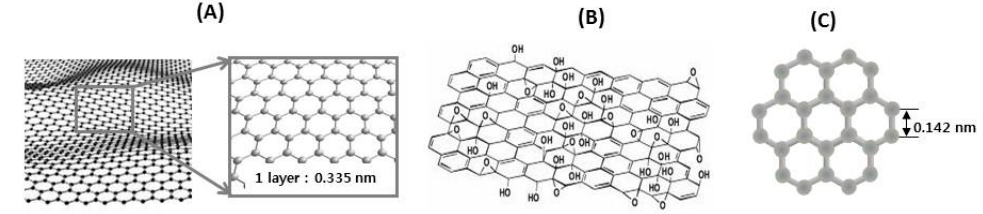
Figure 4. Structures of graphene ( A ), graphene oxide ( B ) and grapheme quantum dot ( C ).